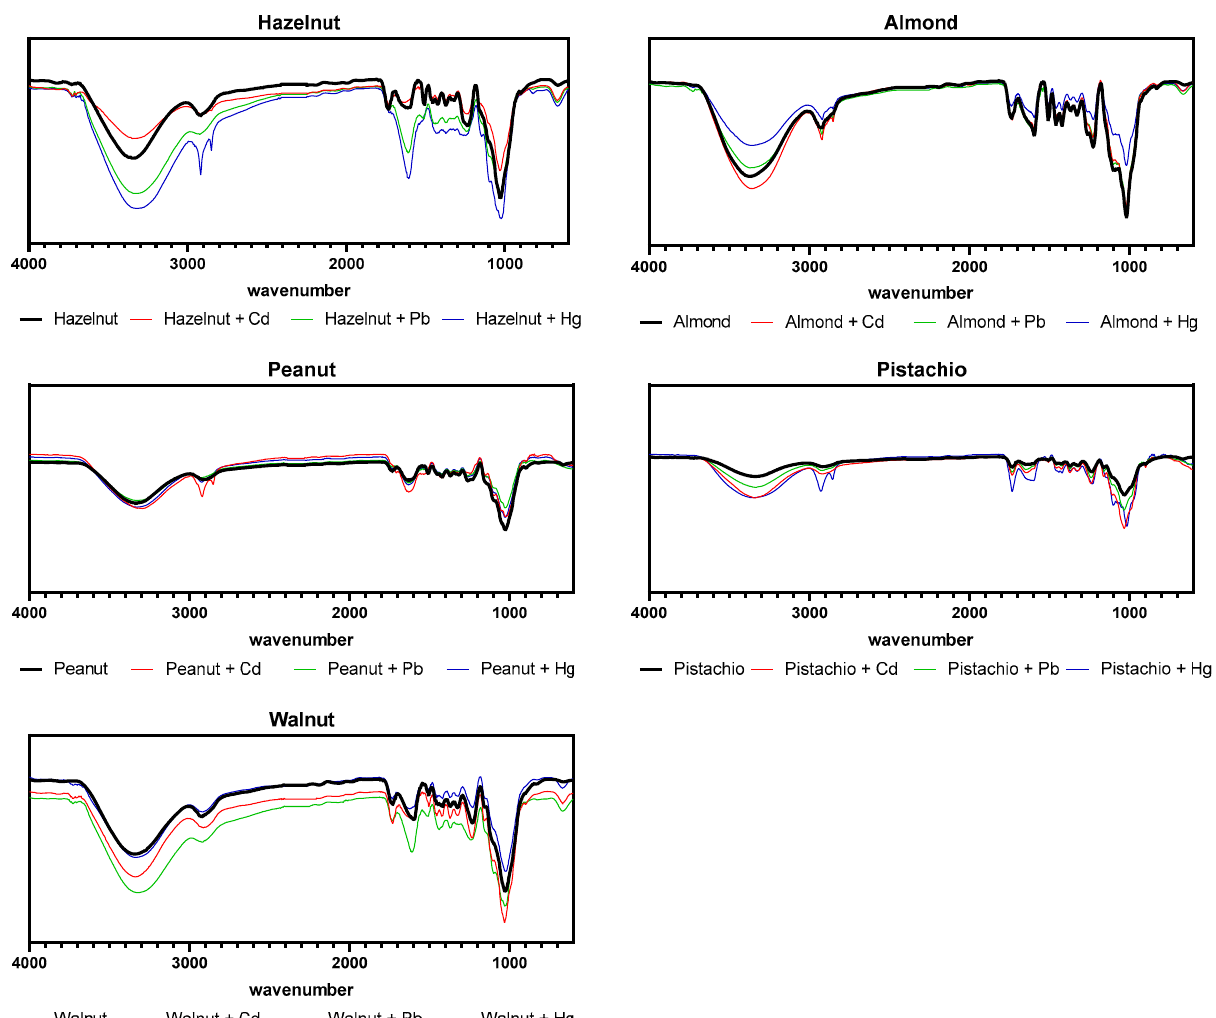
Figure 4. FTIR spectra of the biosorbents before and after exposure to mono-element (cadmium (Cd), lead (Pb) or mercury (Hg) spiked ultrapure water.